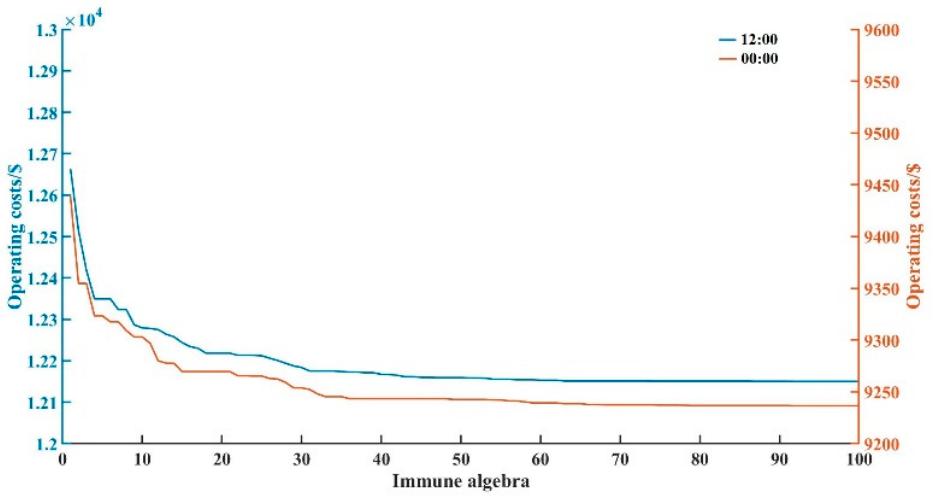
Figure 5. Immune evolution verification curves at 12:00 and 00:00. In this study, the data for the power line, pipeline, and unit investment costs were taken from [33]. The planning results and cost comparisons obtained under the two scenarios are shown in Tables 1 and 2,